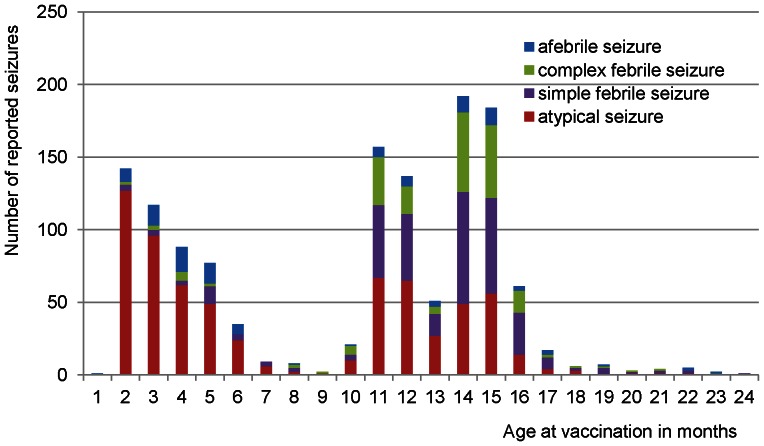
Classification and distribution of reported seizures following vaccinations, according to age at vaccination.